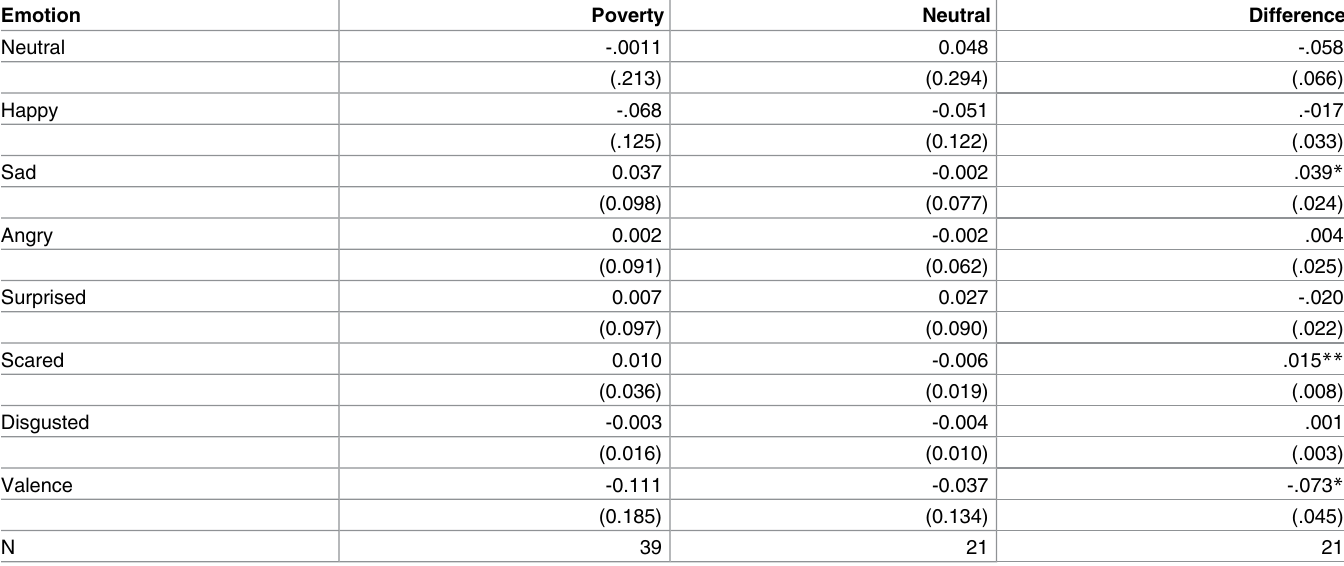
Table 4. Changes in Physiological Measure of Emotions from Before to After the Video, both